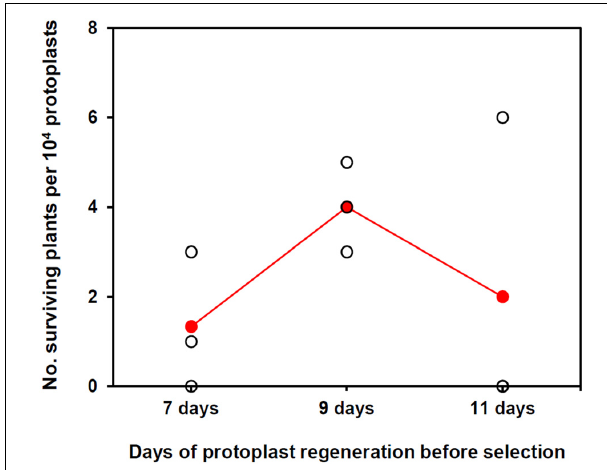
FIGURE 7 | The number of surviving plants after protoplast regeneration for different periods followed by two rounds of hygromycin selection. Colored dots indicate the means of three biological replicates.